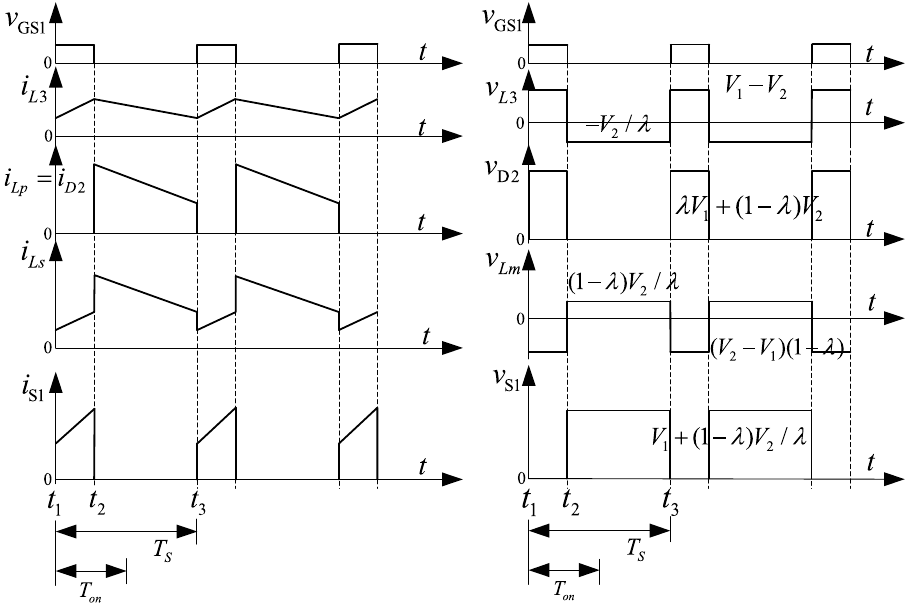
Figure 10. The main operation waveforms of the key components in the step-down mode.